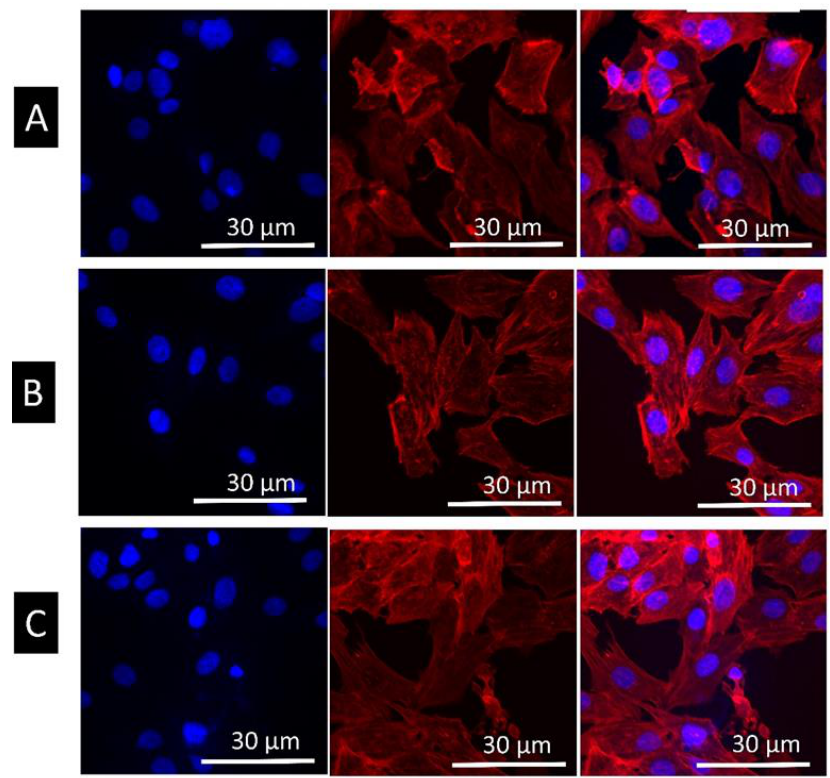
Figure 14. Confocal images of MG63 cells on machined ( A , D ), RT etched ( B , E ), and HT etched ( C , F ) surfaces as cytoskeleton stained with rhodamine-phalloidin and nucleus stained with DAPI after 24 h of culture.